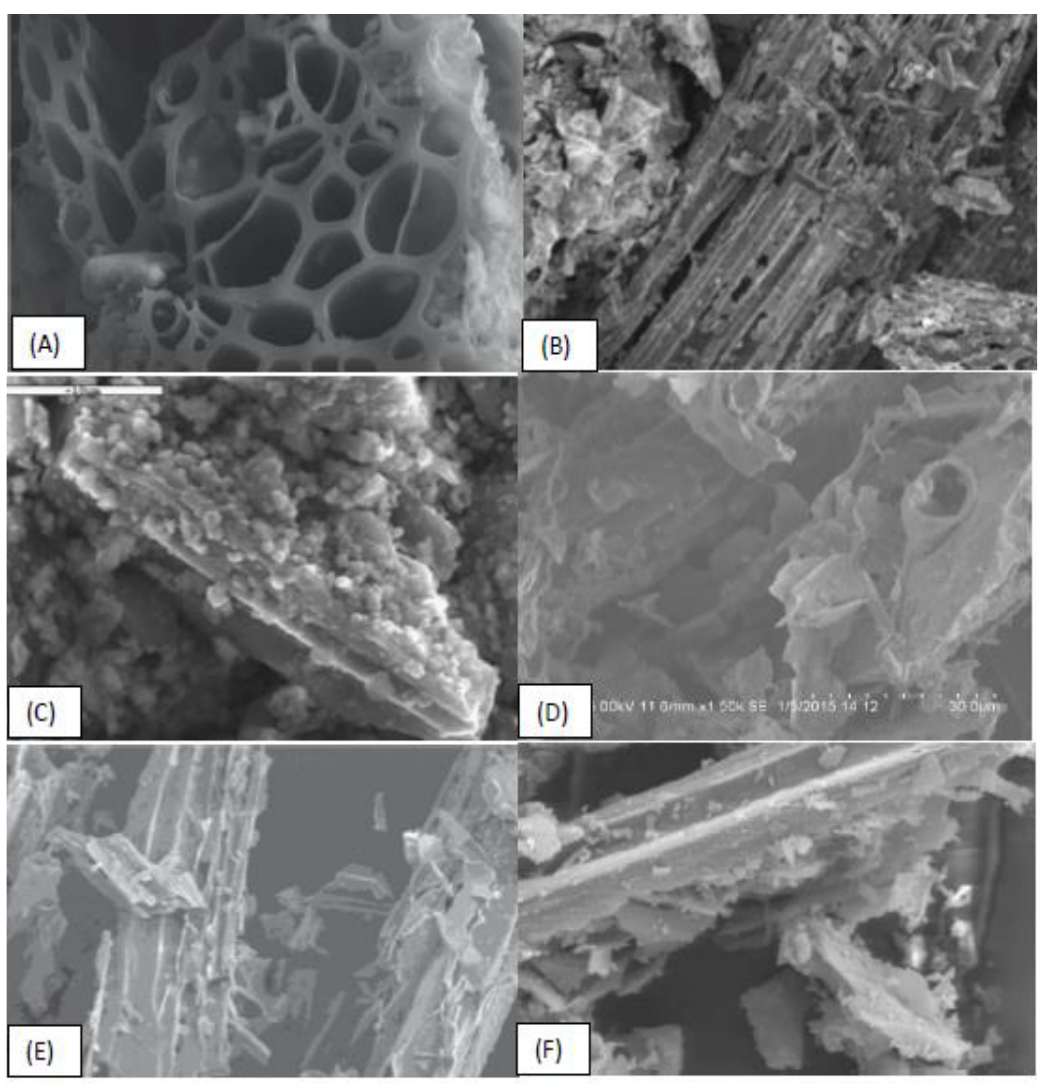
Figure 3. Microstructure of SCBA (source: ( A ) — [ 4], ( B ) — [ 31], ( C ) — [ 45], ( D ) — [ 47], ( E ) — [ 55], ( F ) — [ 63])